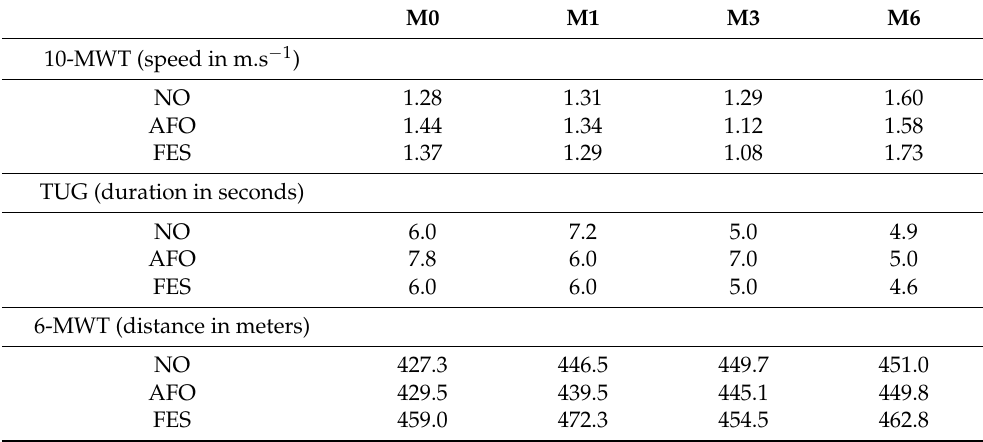
Table 1. Gait parameters for the 10-m walking test (10-MWT), the 6-min walking test (6-MWT), and the time up and go (TUG) test in NO (without any device), AFO (ankle-foot orthesis) and FES (functional electric stimulation) conditions before (M0) and after 1 (M1), 3 (M3), and 6 (M6) months. M0 M1 M3 M6 10-MWT (speed in m.s − 1 ) NO 1.28 1.31 1.29 1.60 AFO 1.44 1.34 1.12 1.58 FES 1.37 1.29 1.08 1.73 TUG (duration in seconds) NO 6.0 AFO FES 6.0 6-MWT (distance in meters) NO 427.3 446.5 449.7 451.0 AFO 429.5 439.5 445.1 449.8 FES 459.0 472.3 454.5